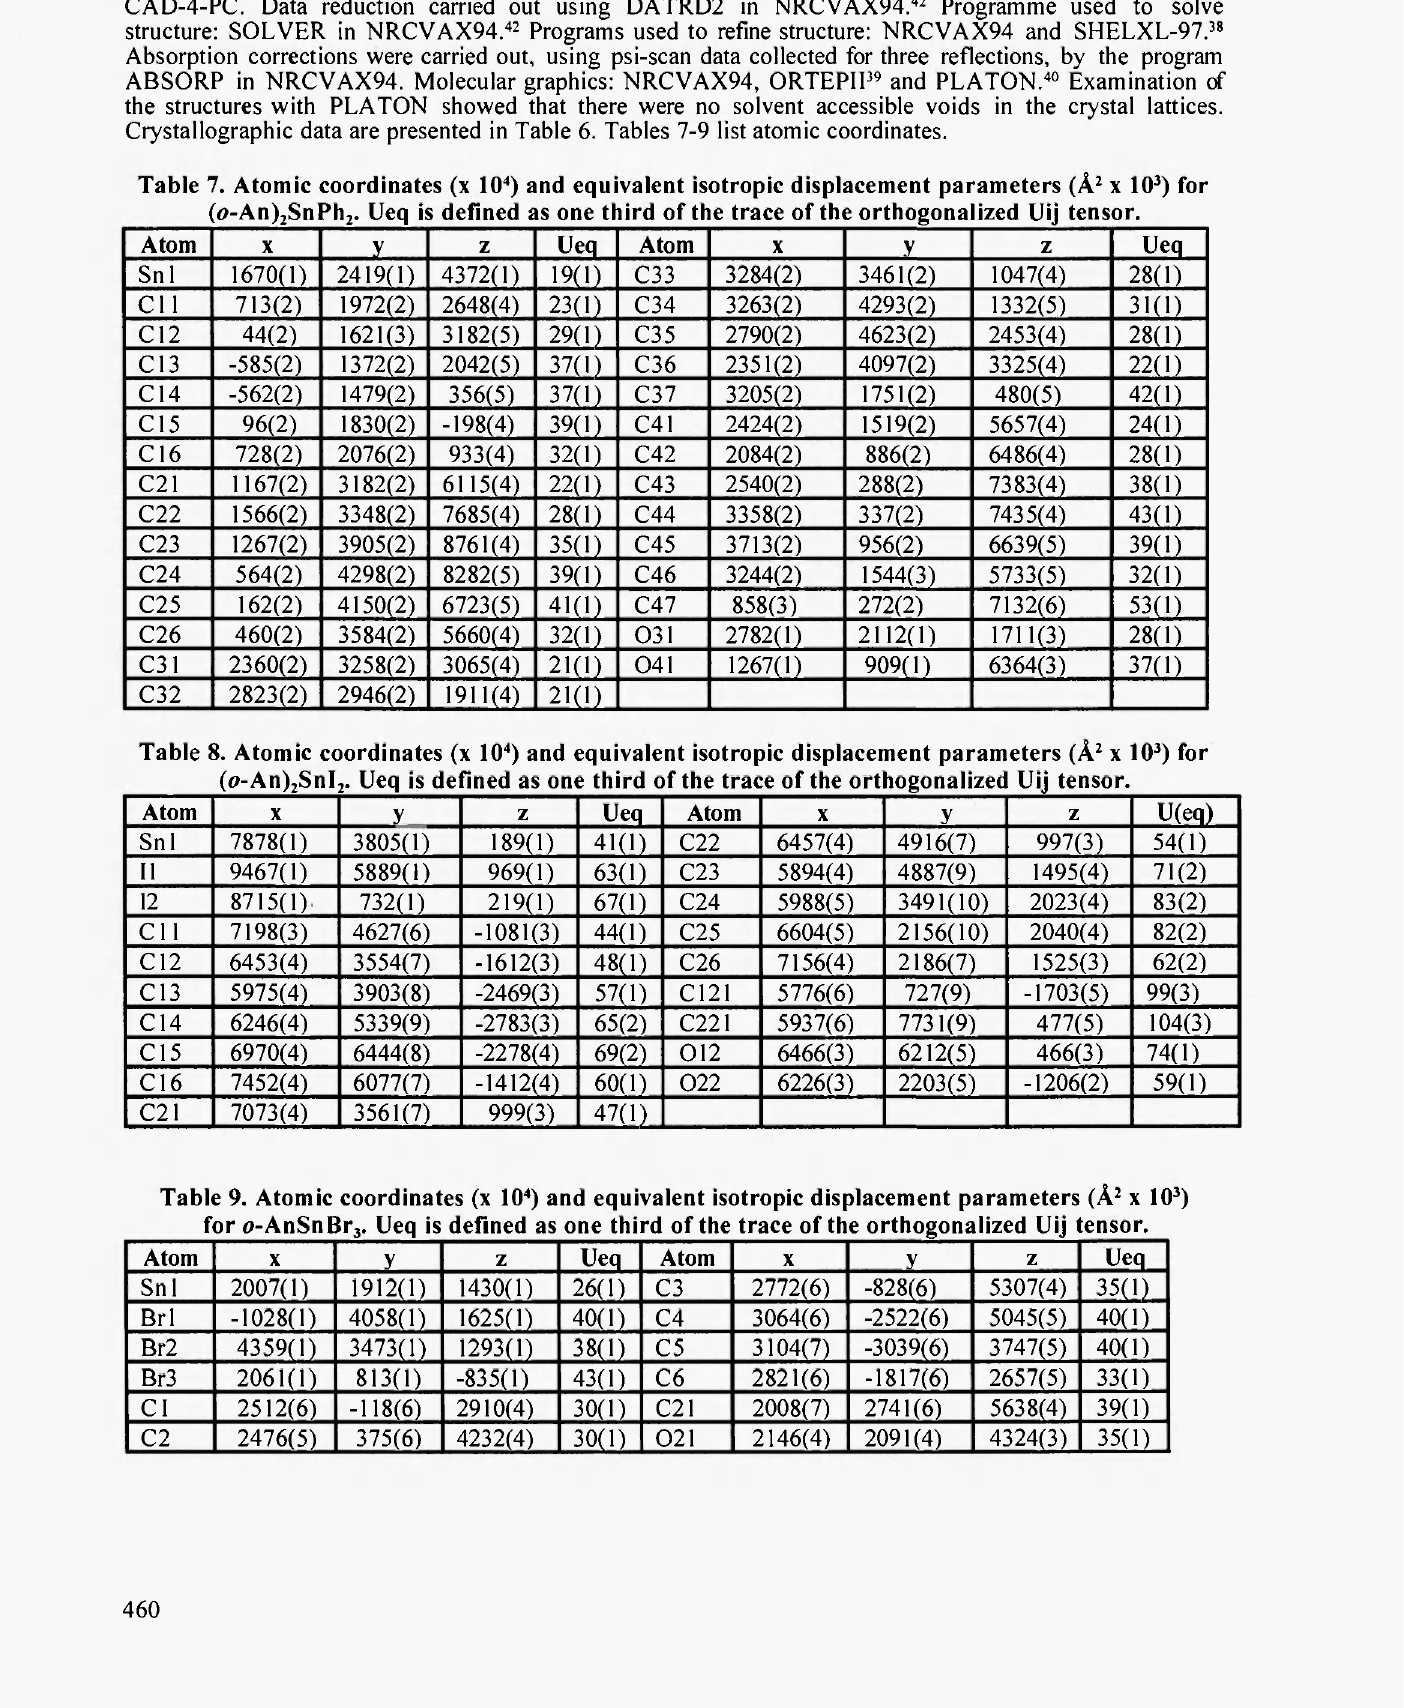
Table 7. Atomic coordinates (χ 10 4 ) and equivalent isotropic displacement parameters (Ä 2 χ 10 3 ) for (o-An) 2 SnPh 2 . Ueq is defined as one third of the trace of the orthogonalized Uij tensor.